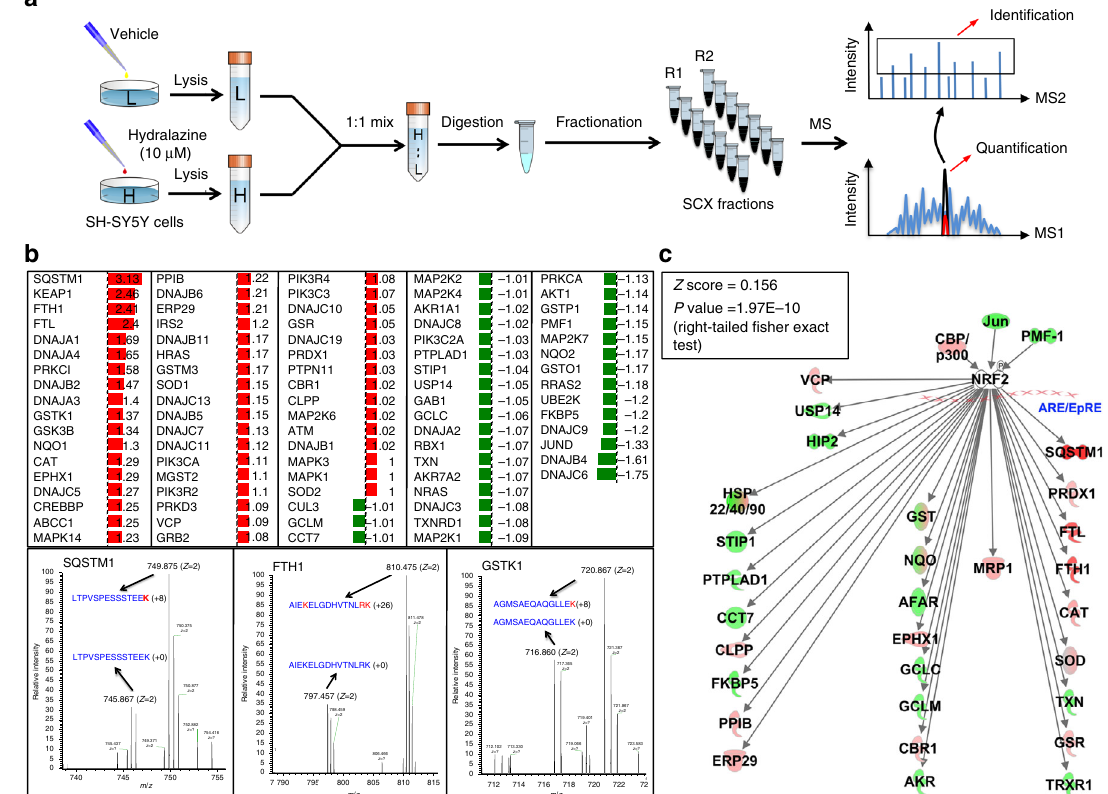
Fig. 2 SILAC screen identi fi es NRF2 pathway activation with hydralazine treatment. a The SILAC work fl ow for identi fi cation of pathways activated by hydralazine ( n = 2). b Proteins with their log2 ratios (treated/untreated) were mapped into the ingenuity pathway analysis (IPA) database where the NRF2 pathway was found activated. Raw MS data for proteins SQSTM1, FTH1, and GSTK1 are also shown as part of the manual validation of the data. c NRF2 pathway activation reported by IPA signi fi ed with Z score of 0.156 and p value of 1.97E − 10, right-tailed Fisher exact